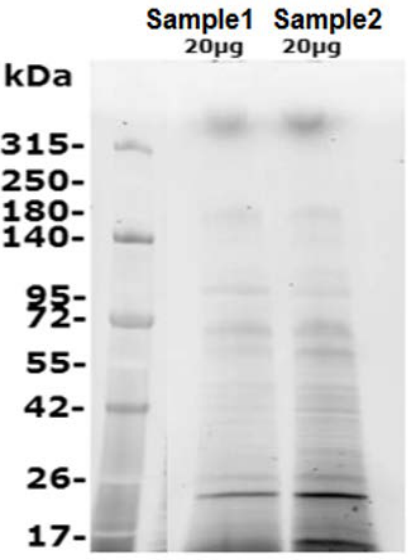
Figure 1. Detection of amoebal proteins using SDS-PAGE analysis. After separation on SDS-PAGE gel, proteins were visualized using stain-free TM detection sample 1 and sample 2: total proteins. Expressed proteins were identified using the Peaks Studio program (Table S2) [57] . A total of 106,383 spectra along with 64,260 peptides were identified. In total, we detected 3,561 proteins, which represented 19.2% of the predicted genes and 40% of the transcriptome (Figure 2 and Table S1).